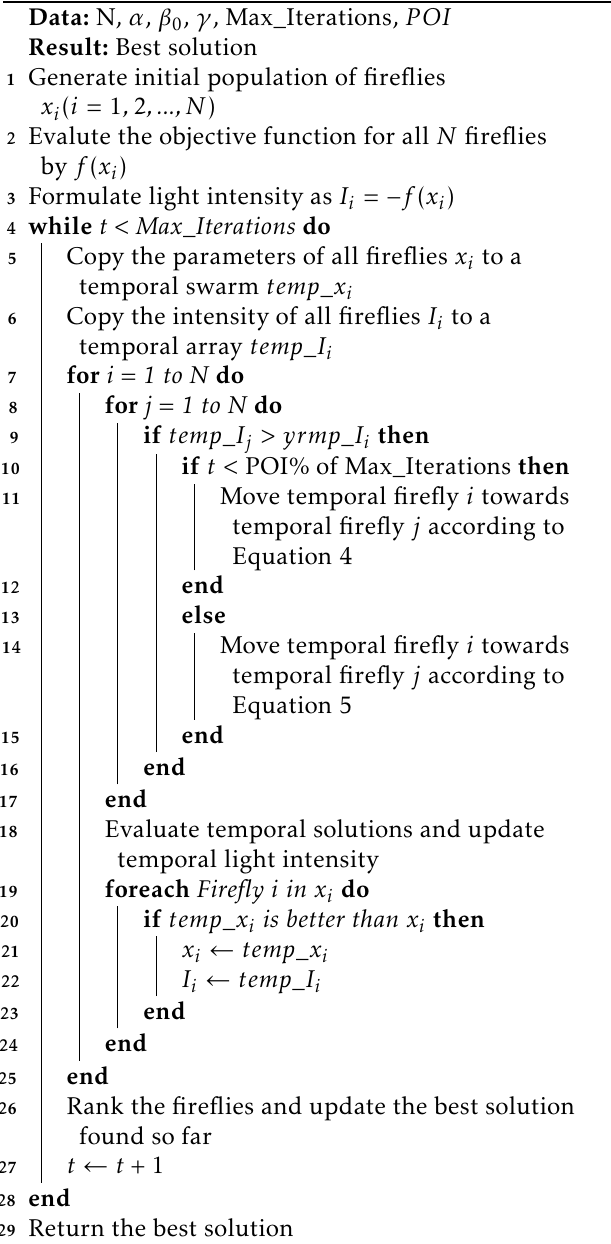
Algorithm 2: Pseudocode of the modified Firefly